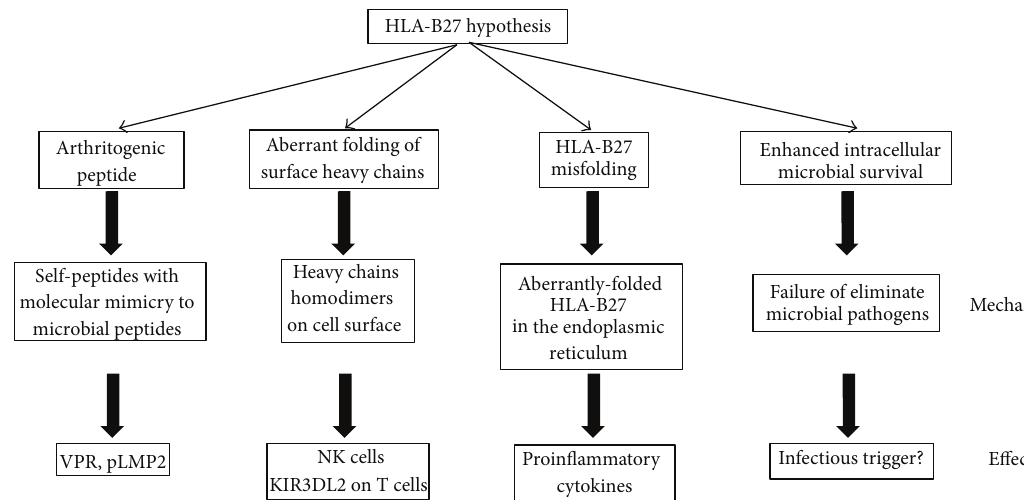
Figure 1: Proposed theories to explain the molecular pathogenic role of HLA-B27 in